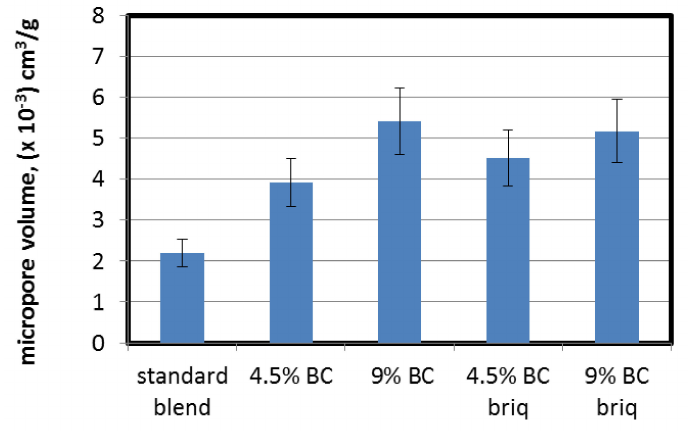
Figure 4. Influence of lignite addition on CO 2 micropore volume of cokes.